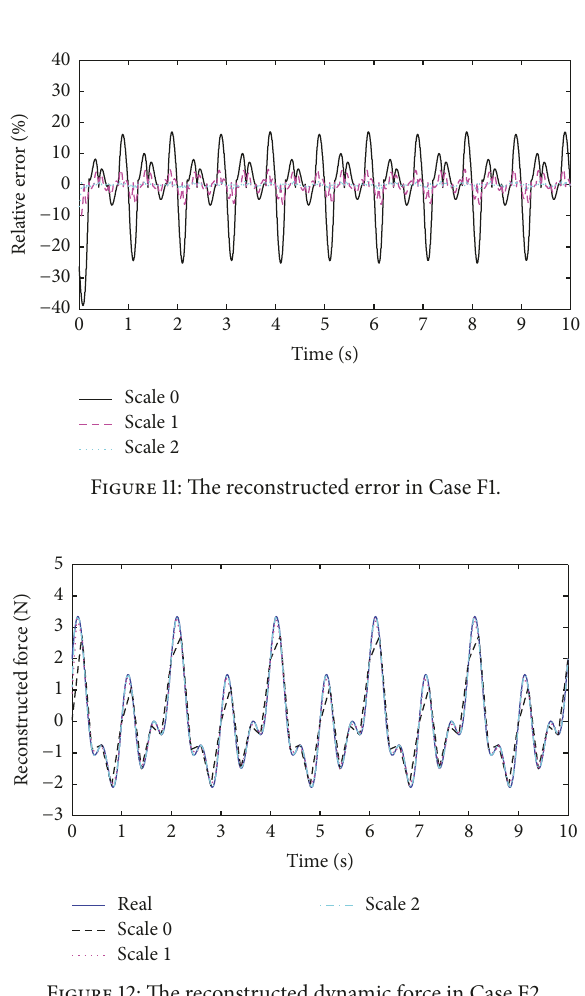
Figure 12: The reconstructed dynamic force in Case F2.